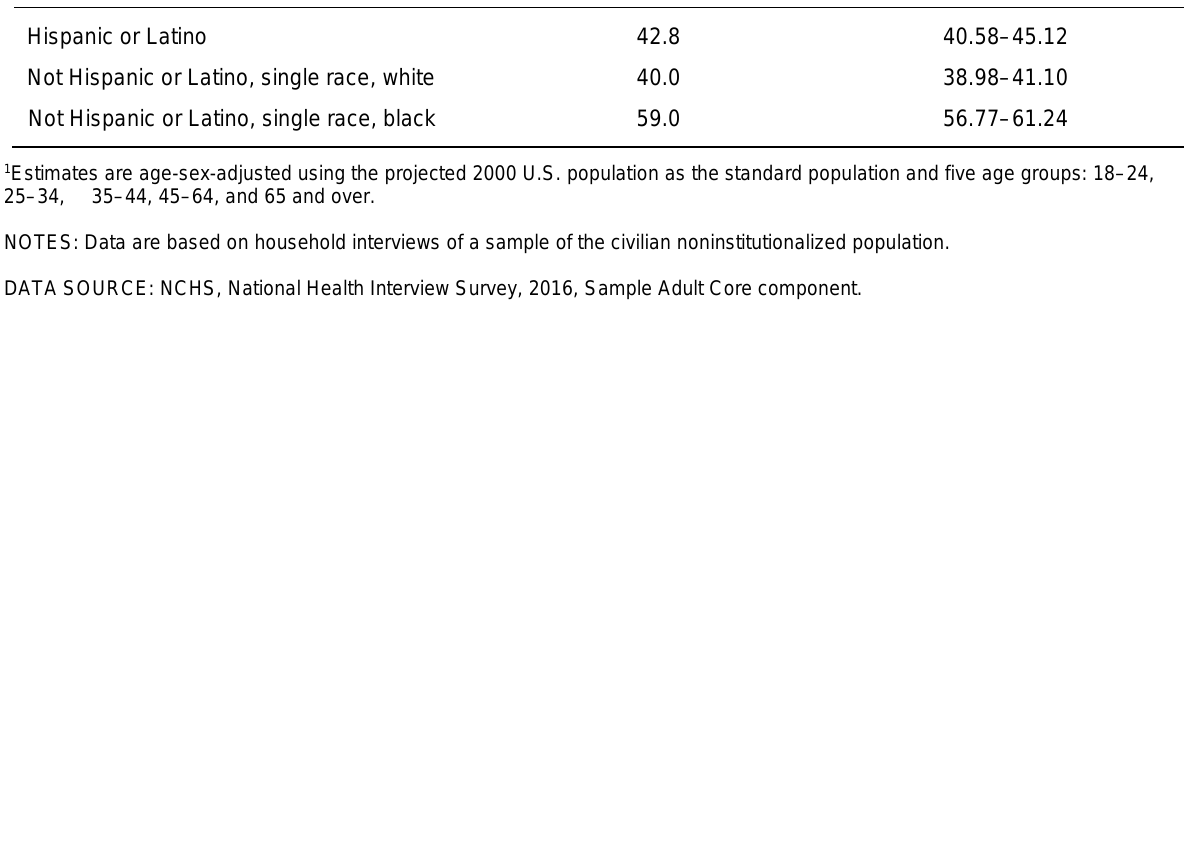
Data table for Figure 10.3. Age-sex-adjusted percentage of adults aged 18 and over who had ever been tested for HIV, by race and ethnicity: United States, 2016 Race and